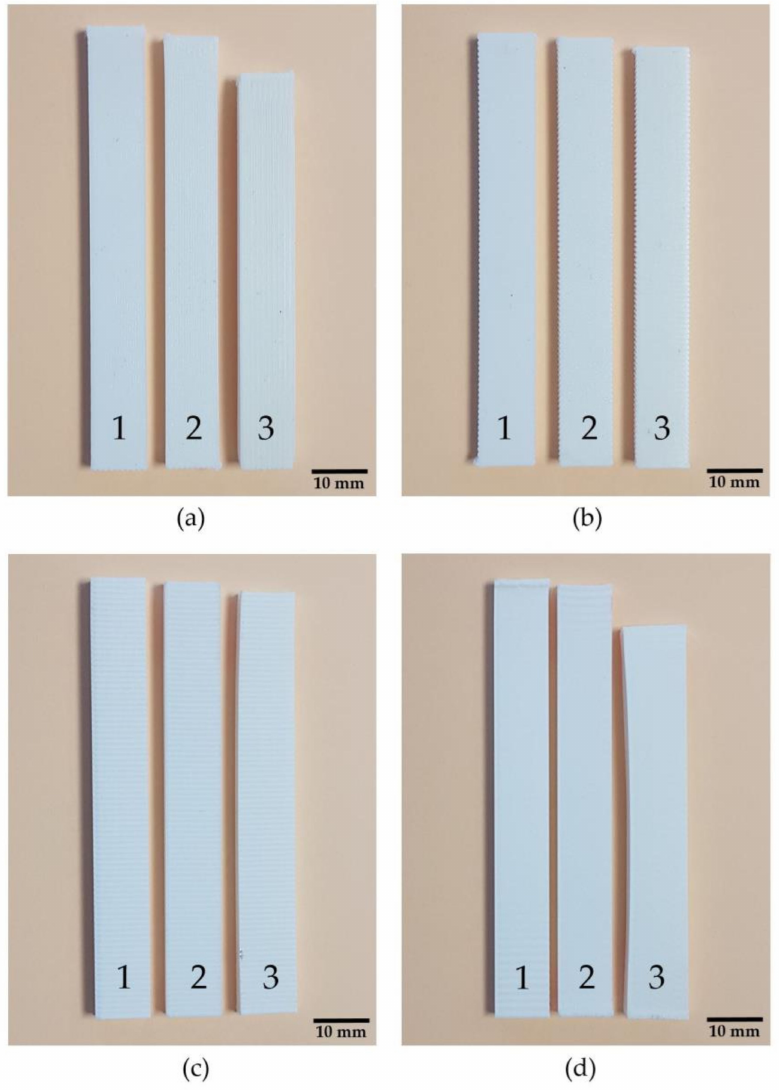
Figure 8. Specimen comparison before thermal process (1), after thermal process with mould (2) and after thermal process without mould (3). ( a ) XY + 0 Samples; ( b ) XY+90 Samples; ( c ) YZ + 0 Samples; ( d ) YZ + 90